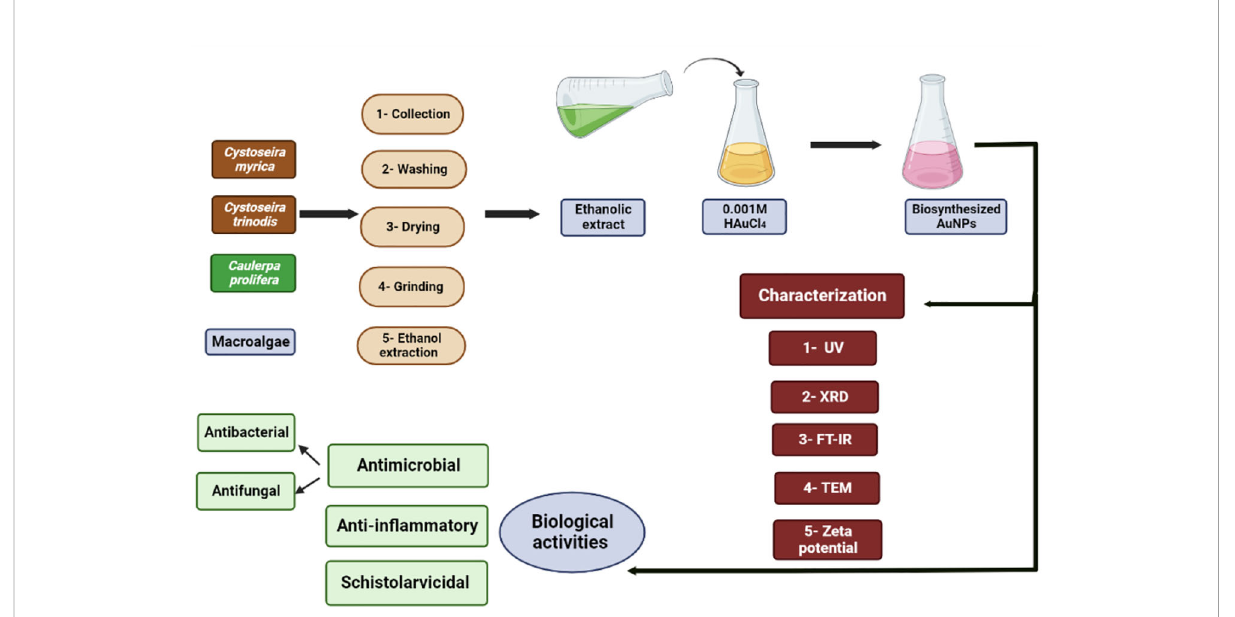
FIGURE 1 Schematic diagram of the experimental methods of the current